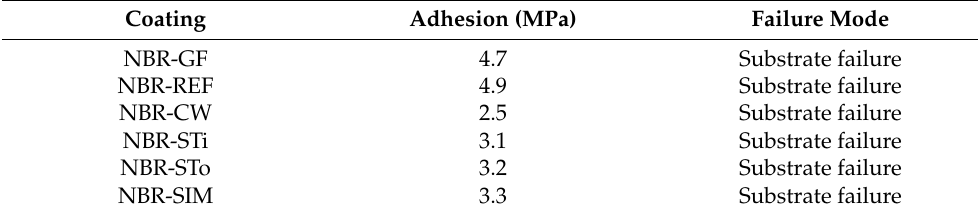
Table 5. Evaluation of the coating adhesion on concrete